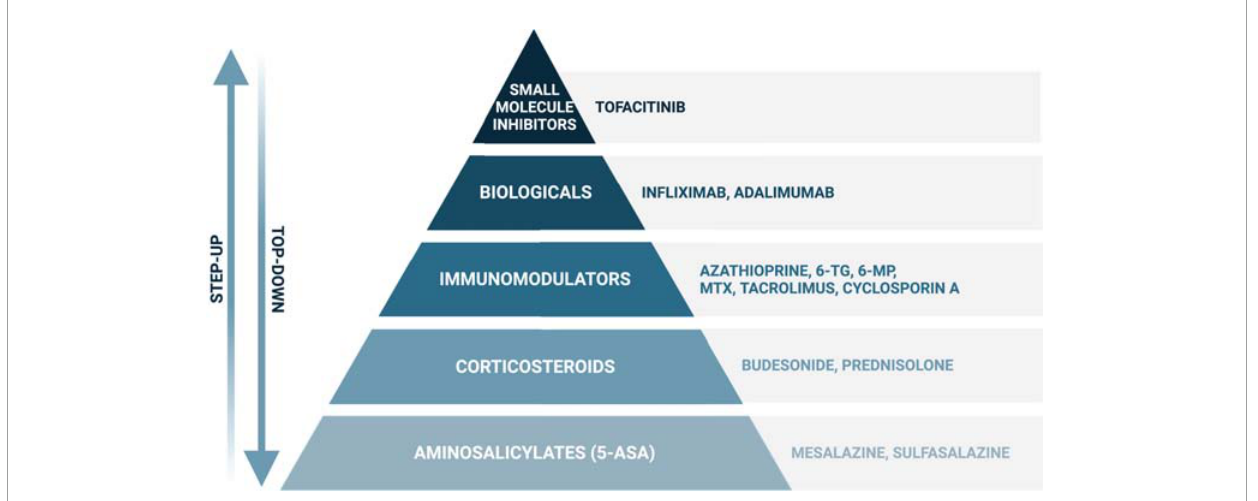
FIGURE1 Simplified scheme of the most frequently used drugs in inflammatory bowel disease. When following the “step up” approach, disease exacerbations will first be treated with aminosalicylates (in ulcerative colitis) or corticosteroids, such as prednisolone and budesonide. In case of failure, or to achieve steroid-free remission, immunomodulators, biologicals, and small molecule inhibitors (in ulcerative colitis) will be considered. A certain drug choice strongly depends on several additional factors, such as disease severity and location, and previous treatment history. The “step-up” approach can be found in the recent guidelines of the European Crohn’s and Colitis Organisation, while evidence is rising favoring the “top-down” approach in certain cases with poor prognostic outcome (Harbord et al., 2017; Berg et al., 2019; Torres et al., 2020). Created with